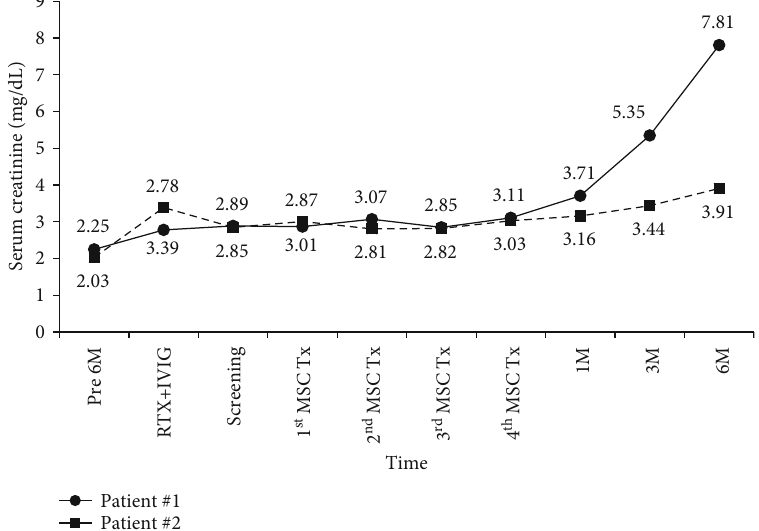
Figure 2: Renal function over time from 6 months before MSC treatment to 6 months after the fi nal infusion. M: months; RTX: rituximab; IVIG: intravenous immunoglobulin; MSCs: mesenchymal stem cells; Tx: